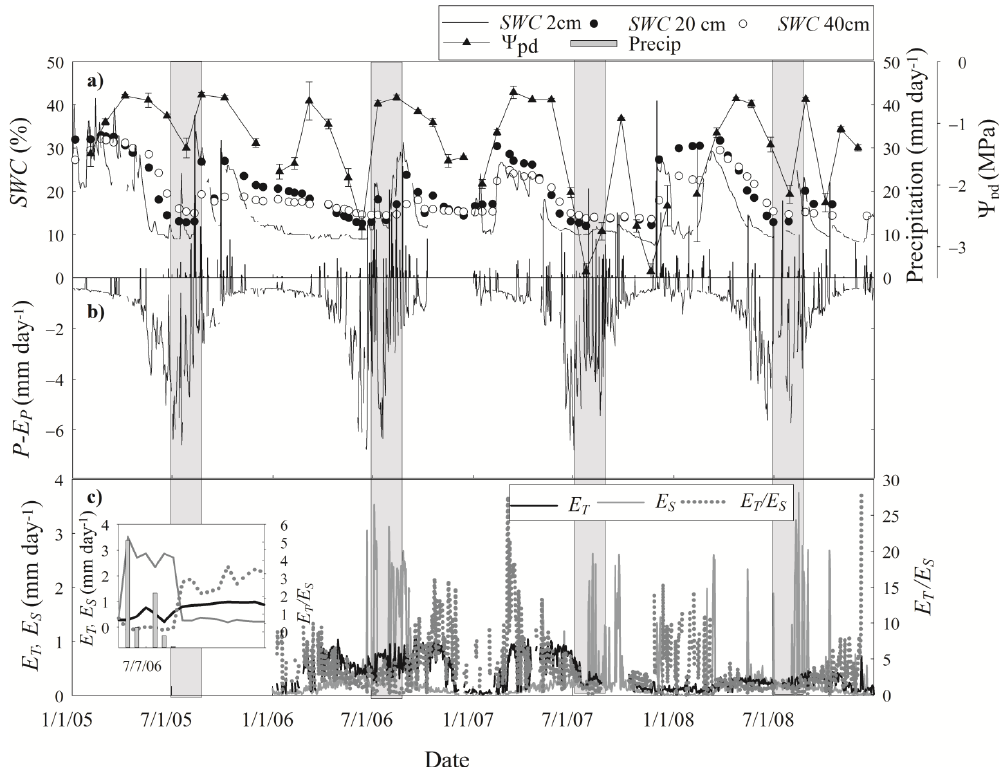
Fig. 1. (a) Time series of precipitation (bars), daily SWC at 2cm (lines), and biweekly SWC at 20cm (circles). (b) Time series of the drought index P − E P (grayed area) and its percentiles (gray line). (c) Time series of modeled soil evaporation ( E S ) from ISOLSM (solid line), canopy transpiration ( E T ) (dashed line), and the E T / E S ratio. We include winter time periods because winter precipitation and soil water content could affect the water cycle during pre-monsoon periods ( ∼ April to June). Typical post-pulse patterns of E S , E T , and E T / E S are displayed as an inset in (c)